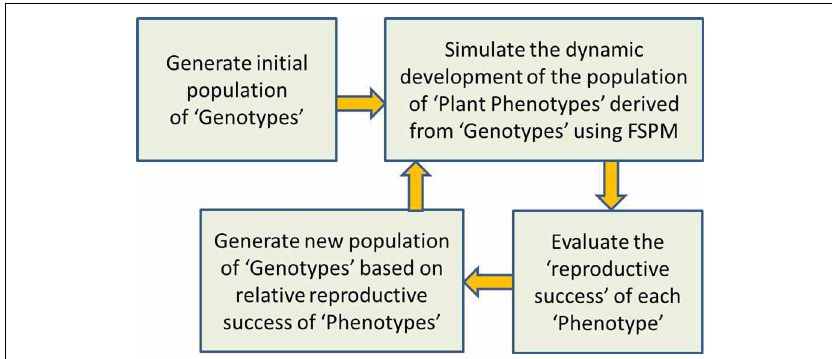
FIGURE 1 | General schema of how an evolutionary algorithm can be combined with a FSPM to investigate the final cause or “evolutionary purpose” of plant growth. The FSPM to be used would have a number of parameters that define its growth strategy, and it is assumed that these parameters represent genetic information that can change with evolution. First an initial “population” of “genotypes” is generated, with each “genotype” consisting of a different set of values for all growth strategy parameters. In step two, the “phenotypic” realization of each “genotype” is simulated with runs of the FSPM, each one corresponding to a set of growth strategy parameters. In step three, the relative reproductive success of each phenotype is determined; this could be based on the final size of the plant for example, with larger plants assumed to produce more seed and pollen and thus be more likely to contribute genes to following generations, all else being equal. In step four, these measures of relative reproductive success are used to generate a new population of genotypes; for example, the genotype of each new seed would be based on the genotype of one or two randomly selected “parent phenotypes,” with the chance of a simulated plant being chosen as a parent depending on its size. Step two is now applied to the new population of genotypes, resulting in a new population of phenotypes, and so the process continues until a specified number of generations have elapsed, or until some other criterion indicating sufficient evolution is